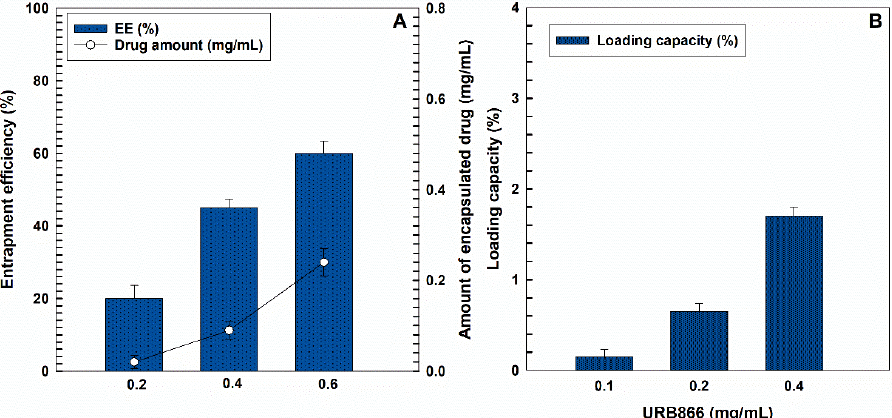
Figure 5. ( A ) Entrapment efficiency (EE, %) and ( B ) loading capacity (LC, %) of URB866 within PLGA nanoparticles as a function of the molecule concentration used during the sample preparation.